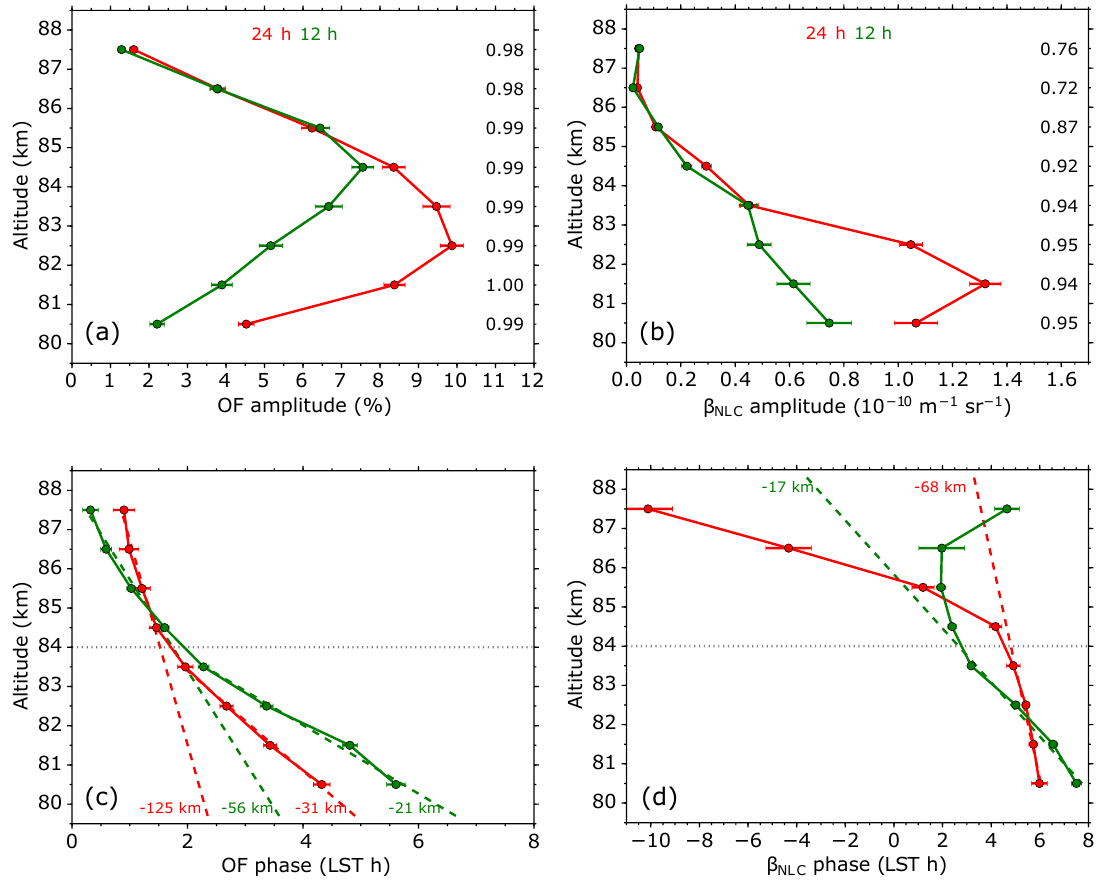
Figure 4. Mean solar amplitudes (a, b) and phases (c, d) of NLC occurrence frequency (OF, a, c ) and brightness ( β NLC , b, d ) between 1 June and 15 August from 1997 to 2017. Diurnal components are in red, and semidiurnal components are in green. Black numbers at the panels a and b are correlation coefficients of the harmonic fits for the corresponding altitudes. Colored numbers in panels c and d are vertical wavelengths as calculated from the phase slopes (dashed lines), separated for altitudes below and above 84km (gray dotted